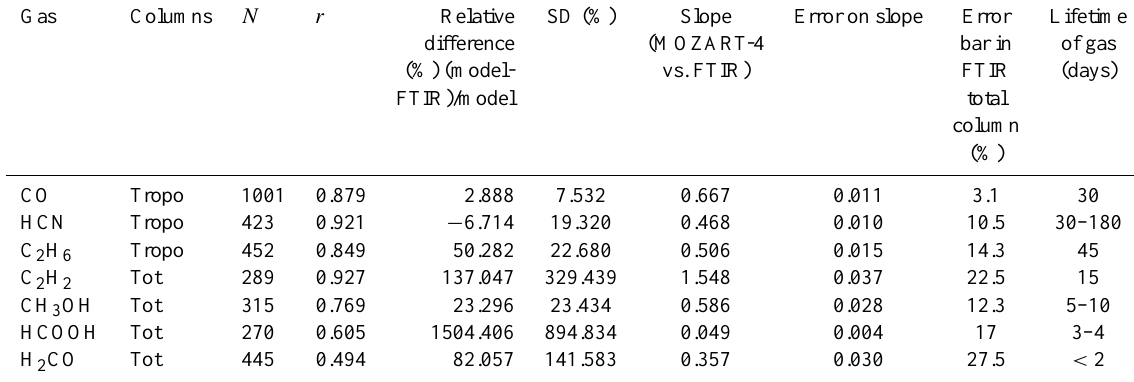
Table 3. Results of the 2008–2012 comparisons between MOZART-4 and the FTIR columns measured at Eureka for the seven species listed in the first column. The comparisons are made for the tropospheric columns (0.6–10.25km) for CO, HCN and C 2 H 6 and for the total columns (for the other gases). N is the number of points included in the comparisons and r is the coefficient of linear correlation. The relative differences (in percentage) are calculated as (model-FTIR)/model, and SD is the 1-sigma standard deviation around the mean difference. The last four columns are the slopes of the linear regression lines between MOZART-4 and FTIR along with their errors, the error bars in the FTIR total columns (in percentage), and the atmospheric lifetimes of the target species.